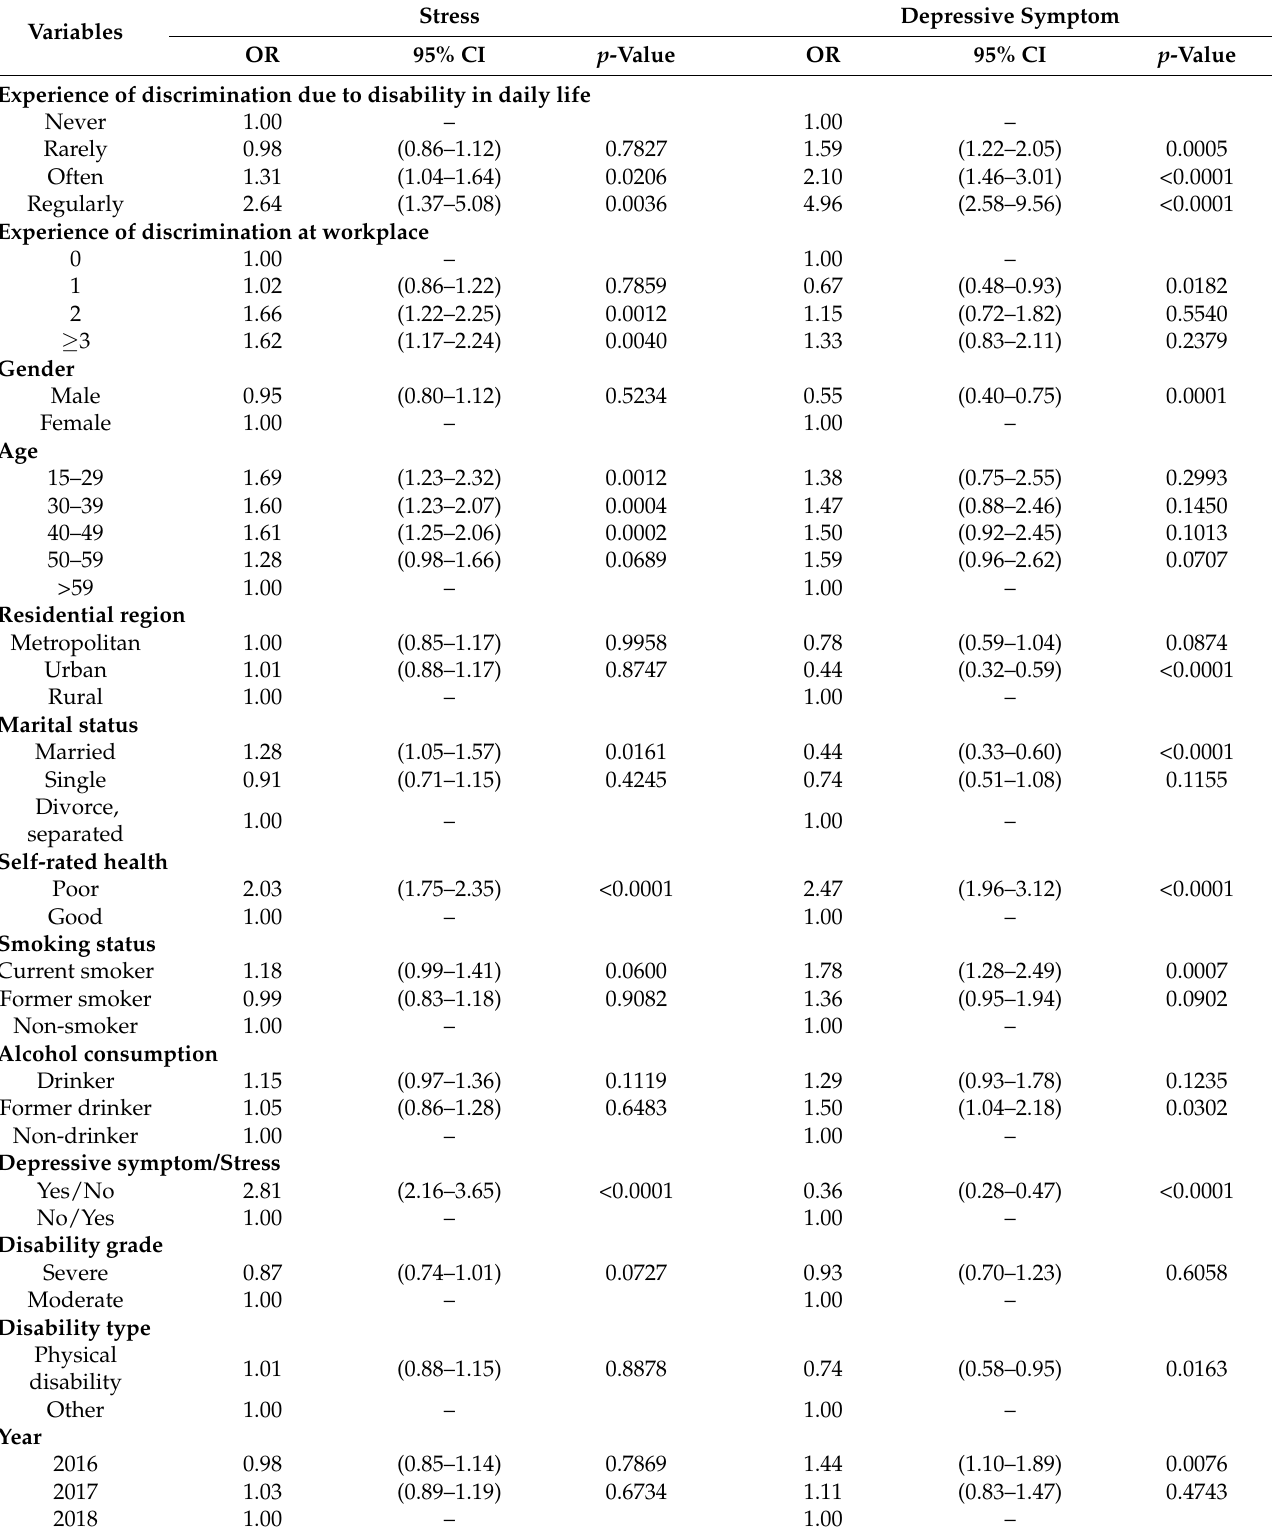
Table 4. Results of the analysis including both discrimination experiences and stress/ depres- sive